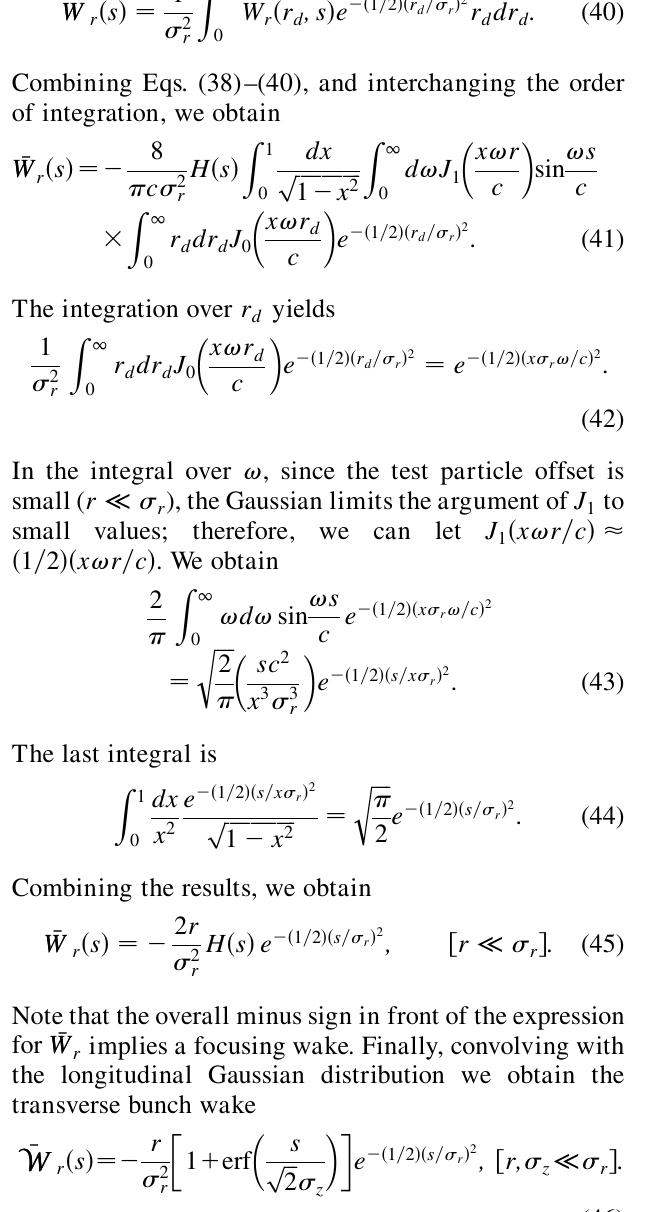
the shape of the wake z z